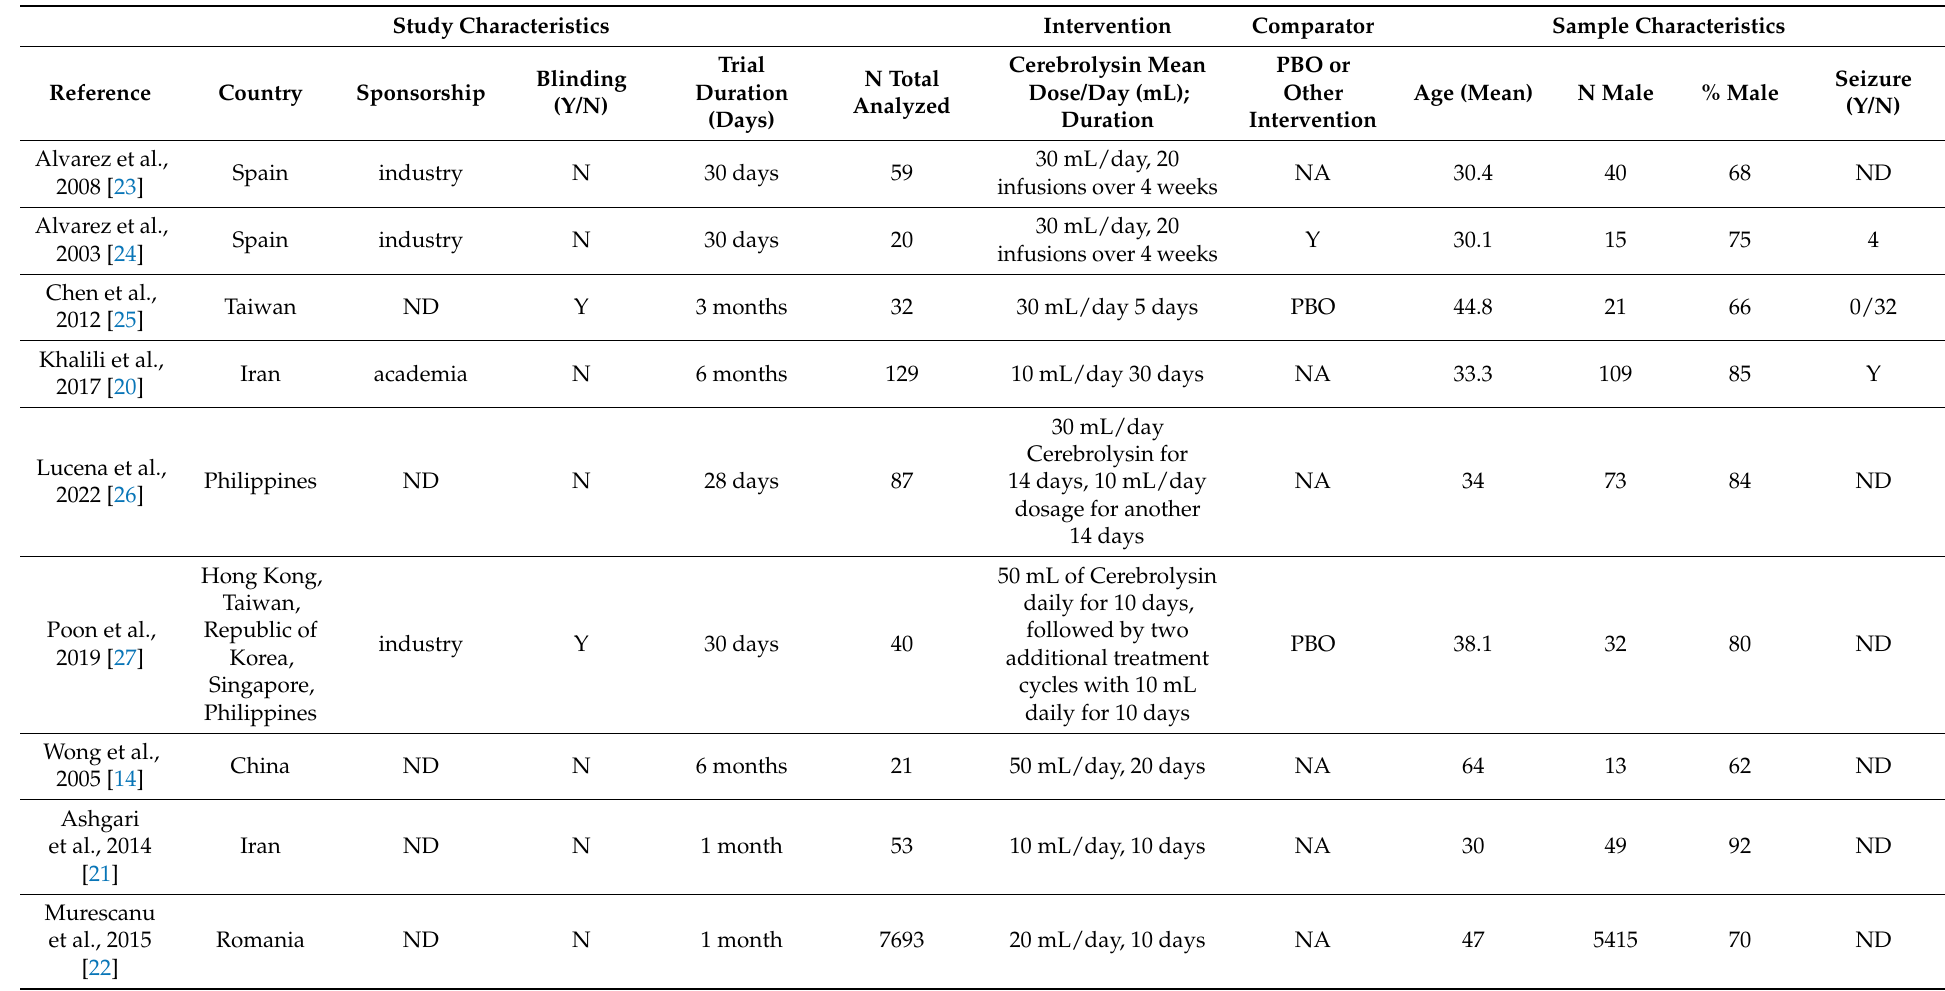
Table 2. Study and patient characteristics. ND—no data, PBO—placebo, NA—not